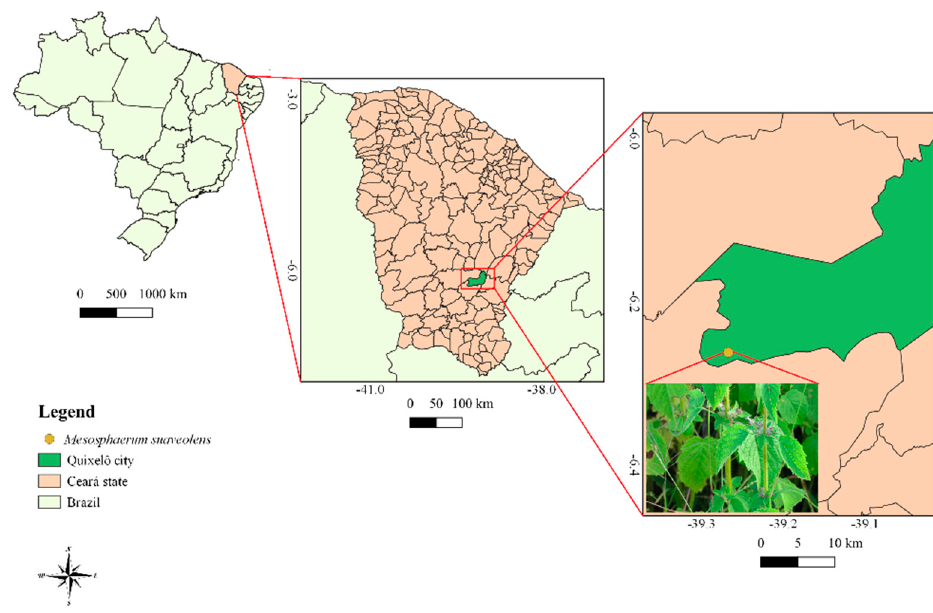
Figure 6. Map of the Mesosphaerum suaveolens species collection in the Municipality of Quixelô, CE, Brazil.